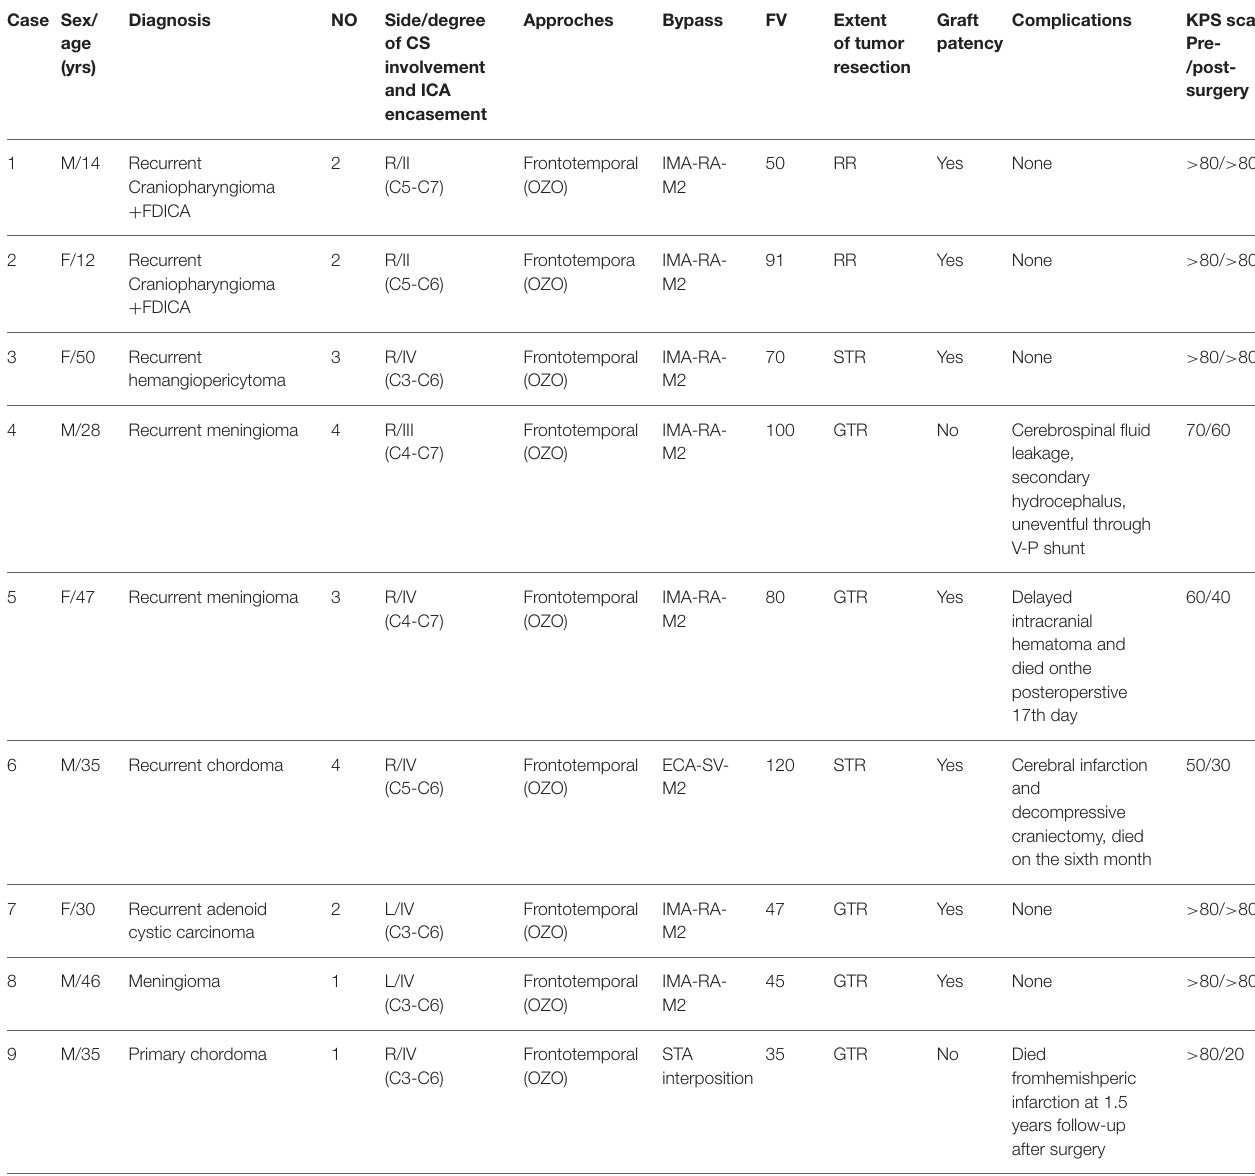
TABLE 1 | Demographic data of 9 patients of skull base tumors treated with adjunctive bypass surgery. Case Sex/ age